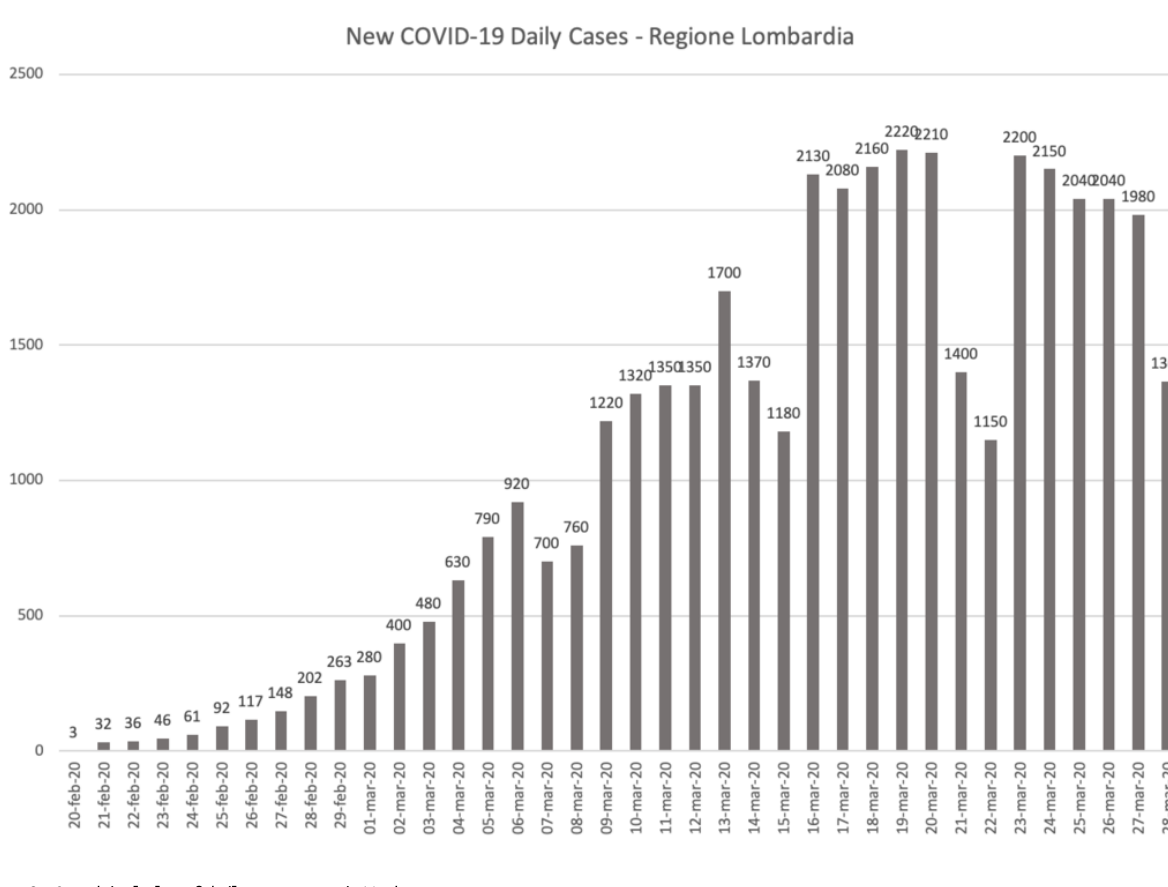
Figure 6. Graphical plot of daily new cases in